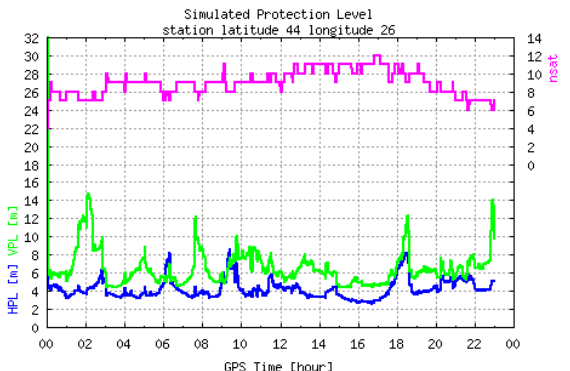
Figure 13. Ionospheric part of the vertical and horizontal Protection Level with the number of satellites. The simulated site is in Bucharest on